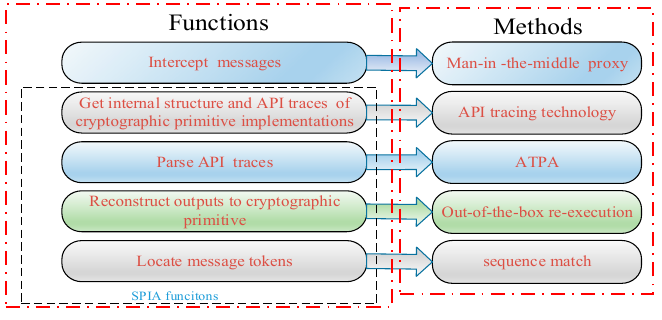
Figure 1. Core functions and corresponding methods.